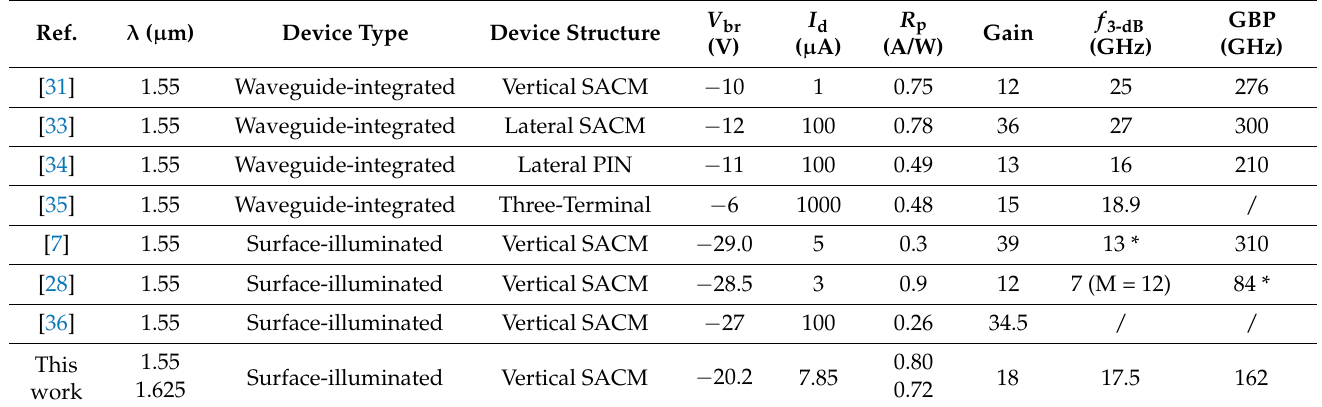
Table 2. Performance comparison of reported Ge/Si